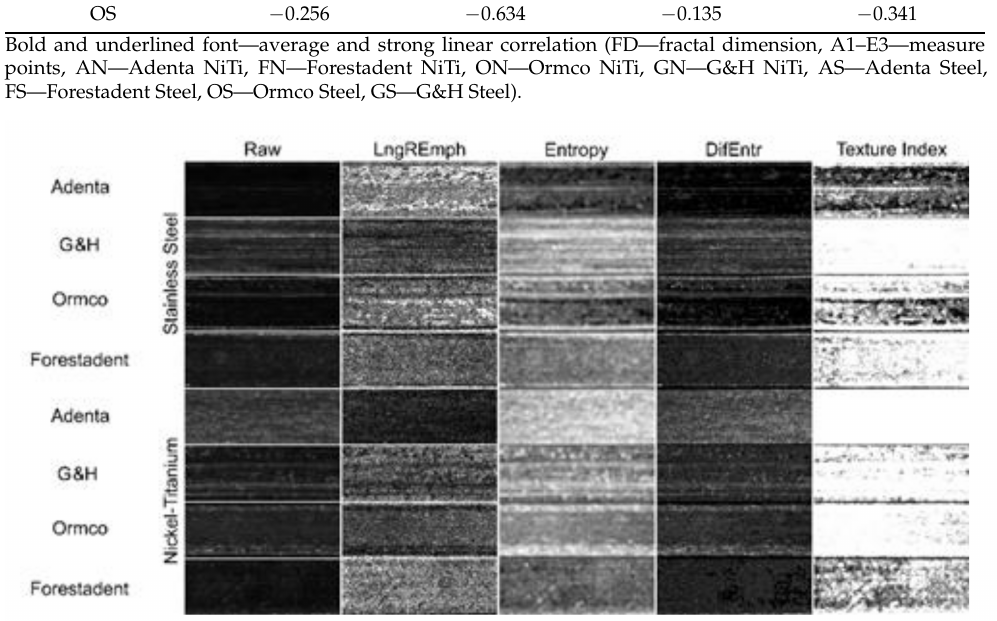
Figure 4. Texture analysis. Surface image transformations of example orthodontic wire samples made of stainless steel and nickel-titanium. Raw (microphotography): Light microscope images. The brighter places correspond to flat smooth areas that reflect visible light more strongly due to this surface. LngREmph: A feature of the series length matrix that reveals areas that similarly reflect incident light. White areas (high values of this texture feature) correspond to elongated horizontal micro-reflections of similar light. This feature does not differentiate continuous dark areas from continuous light areas. Entropy: Reveals a surface with evenly scattered areas of similar brightness (smoothness). Note that Entropy remains in opposition to LngREmph, i.e., areas of high LngREmph feature values occur in areas of low Entropy value, and vice versa. DifEntr: Enhances (shows as whiter) areas made up of evenly scattered areas similarly reflecting incident light (similar surface smoothness). This feature more strongly differentiates the analyzed surface into poorly differentiated areas (black) and highly differentiated areas with a chaotic arrangement of smooth plots (white). By comparing the appearance of this map with the photographic image it can be concluded that the smooth areas of the photographic image correspond to an accumulation of areas of high Difference Entropy. Texture Index (TI): the white areas represent high TI values on the wire surface in the map. The darker the area, the lower the TI value represented by that region. The texture of the wire surface is represented by a lighter area the smoother areas originally entered the archwire photographic image at that location (see next figures), magnification 36 ×